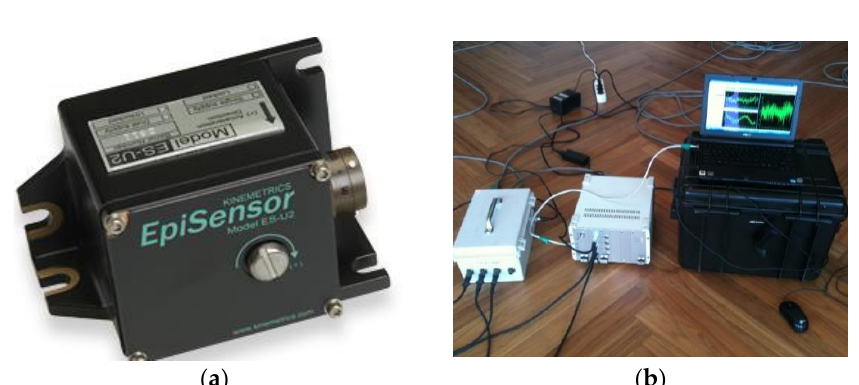
Figure 2. Equipment for ambient vibration measurement: ( a ) accelerometer (Kinemetrics Episensor ES-U2) and ( b ) data logger (Netpod 4003, Keynes Control Co.).